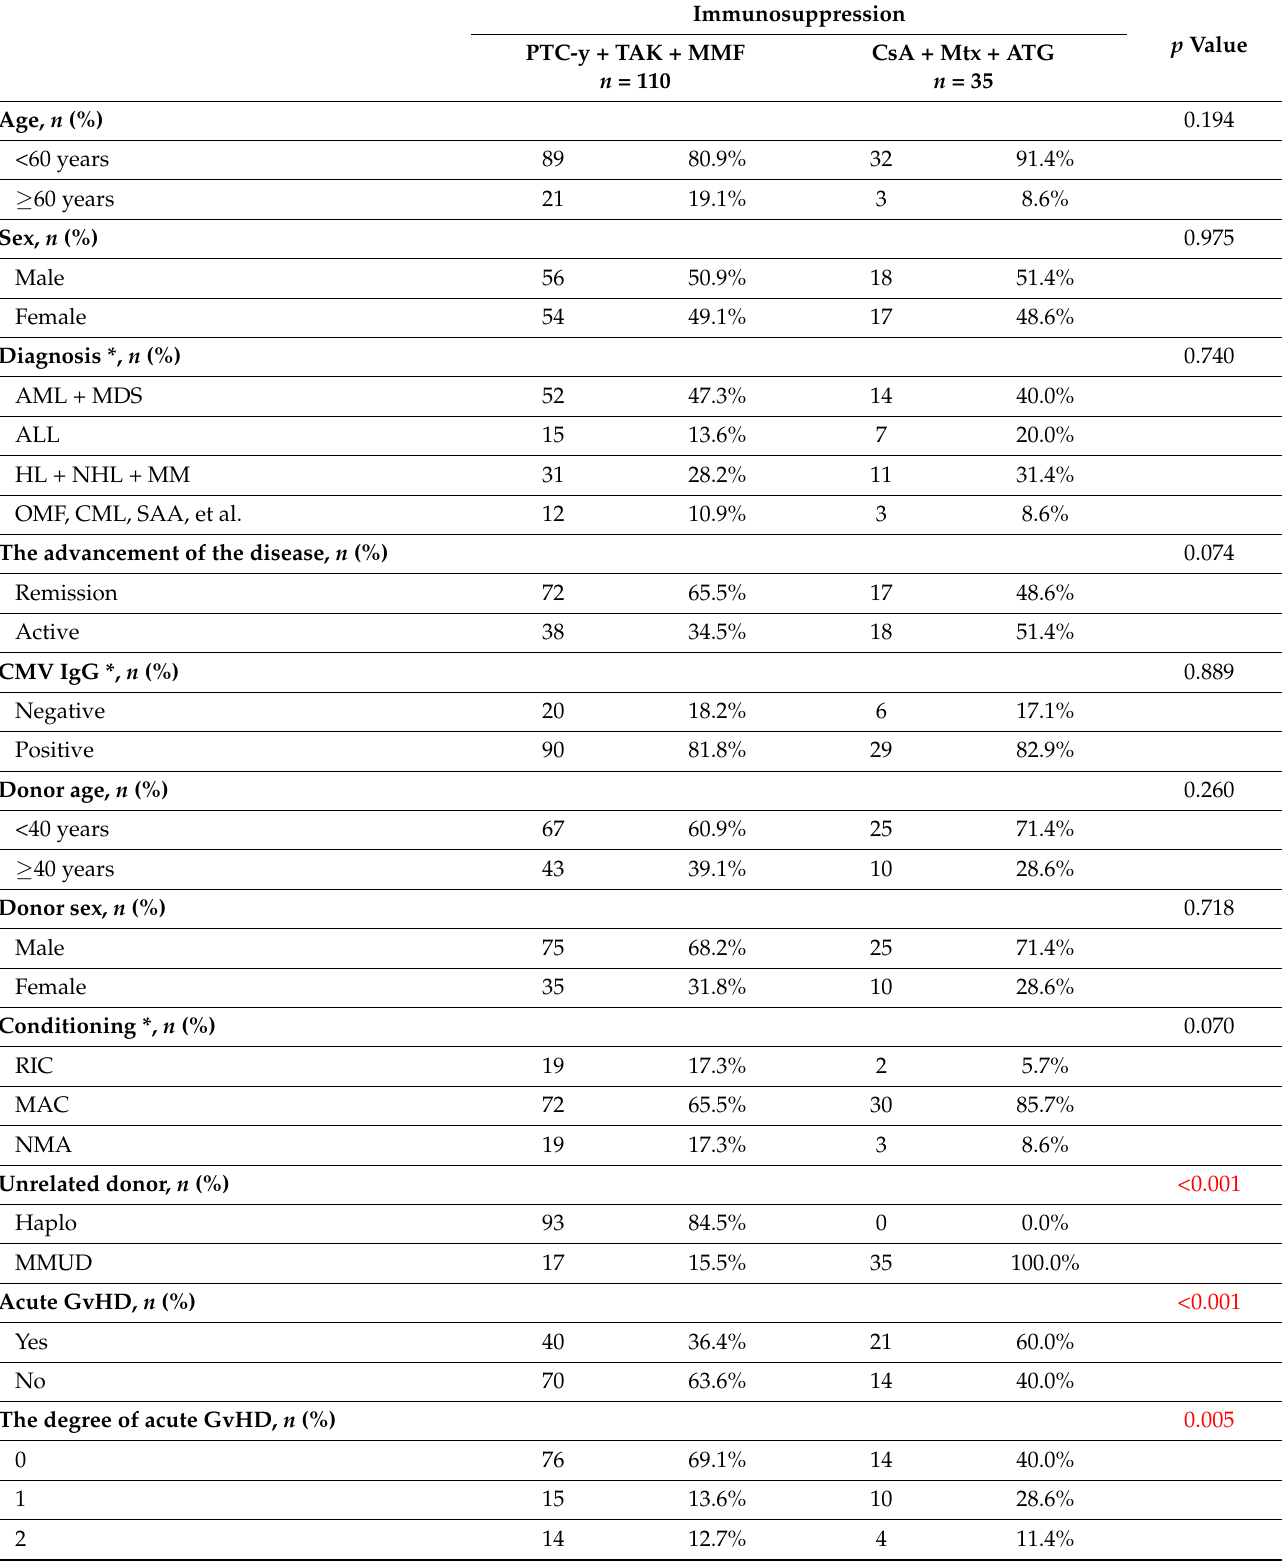
Table 1. The characteristics of patients receiving different types of immunosuppressants,